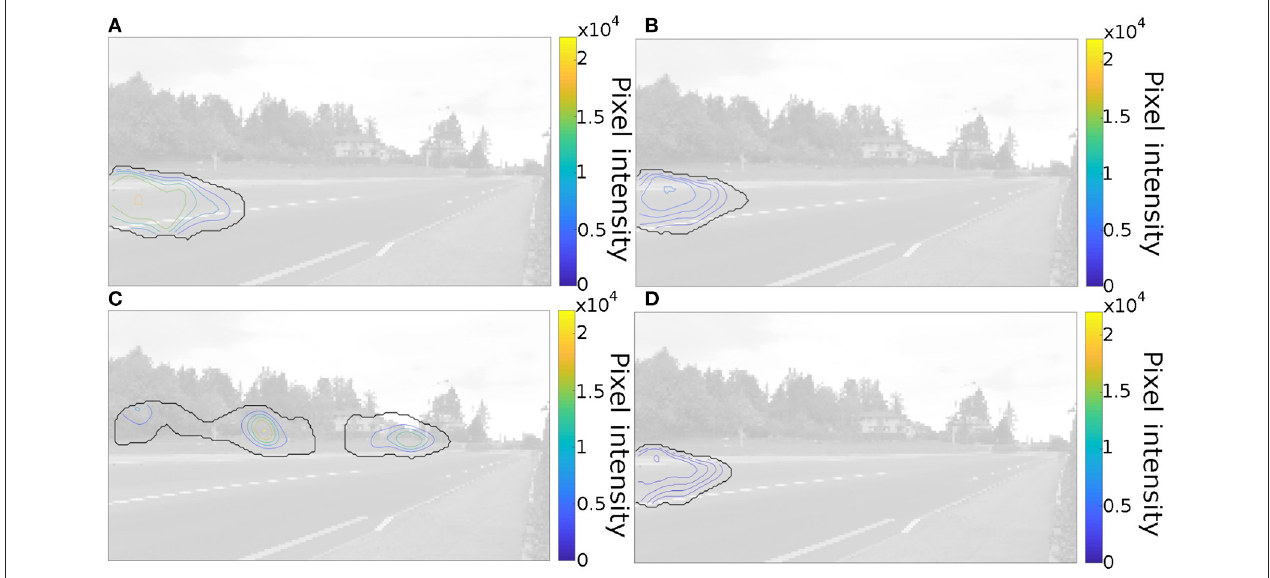
FIGURE 3 | Statistical gaze maps created using iMap4 (Lao et al., 2017) for the main effects of global (A) and local (B) switch costs on the RMA task. As well as the main effect of pedestrian presence (C) , and the interaction between local switch cost and age group (D) . Black lines encircle areas gazed at significantly